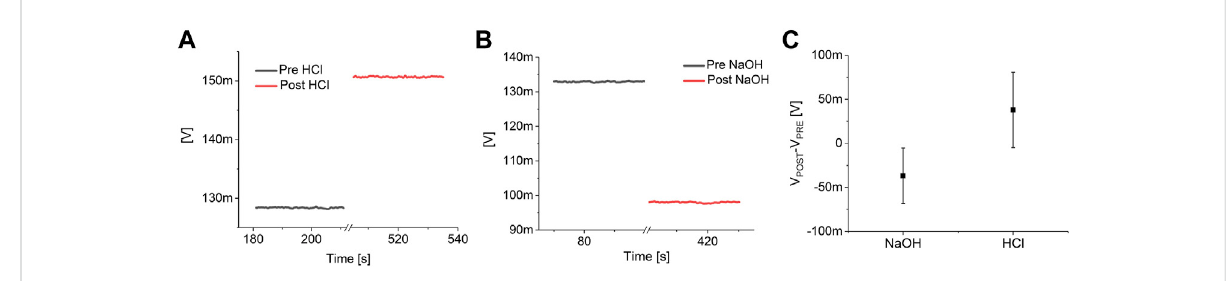
FIGURE 2 pH response analysis. Example of the response of a pH channel of a MOA without the cells to a strong acidi fi cation (A) and basi fi cation (B) . (C) Analysis on the effect of a strong acidi fi cation (pH 7.3 to pH 1) and basi fi cation (pH 7.3 to pH 13) on six blanks (three blanks each).